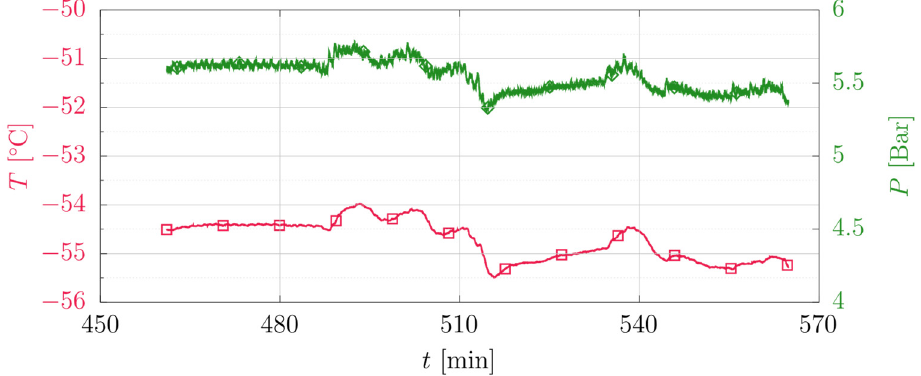
Figure 3. Pressure and liquid temperature in SV02 during the controlled stepwise reduction in pressure in Experiment 1 from 5.6 bar to 5.4 bar.